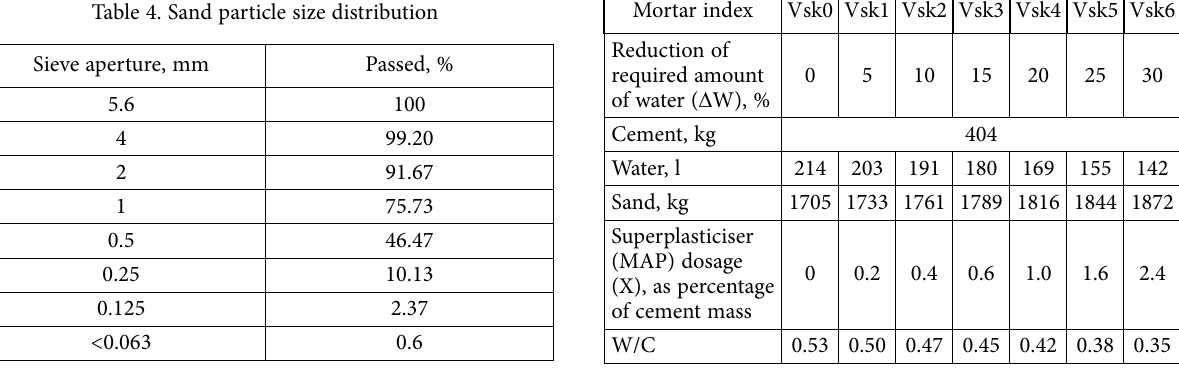
Table 5. Compositions of 1 m 3 of mortar Mortar